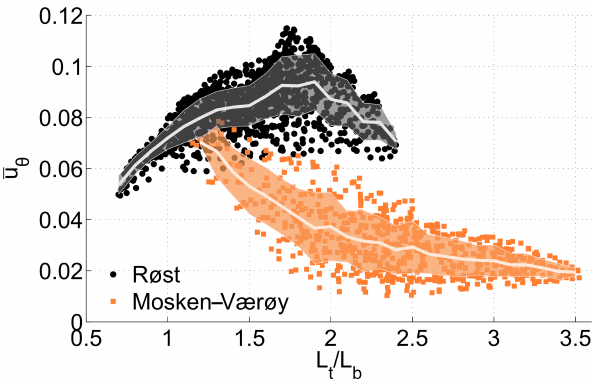
Figure 16. The strength of the rectified tidal currents around Røst (black dots) and around Mosken–Værøy (orange dots) are plotted against the ratio L T /L B averaged around closed depth contours. Each dot corresponds to a time-mean velocity averaged over one tidal cycle. The bright thicker lines show the mean values of the residual tidal current corresponding to a given value of L T /L B ± 0 . 1. Shading indicates 1 standard deviation around the mean.